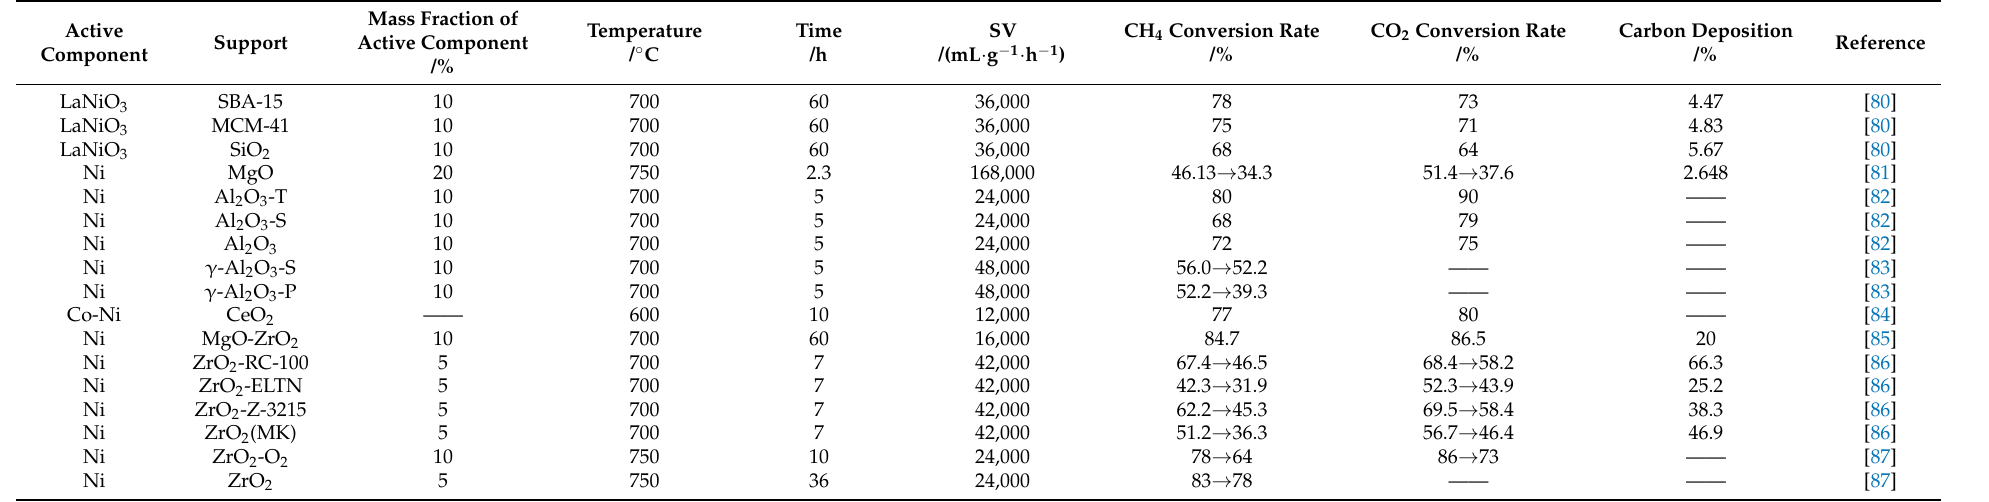
Table 1. Catalytic performance of Ni-based catalysts with different